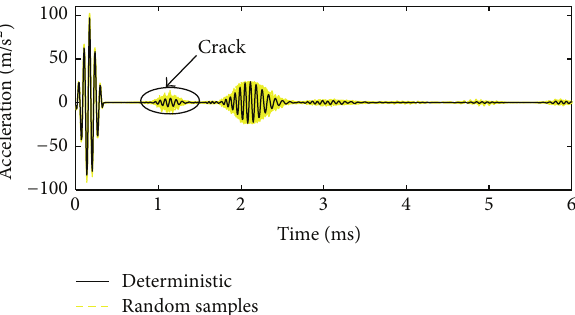
Figure 9: Comparison between deterministic and random system response.